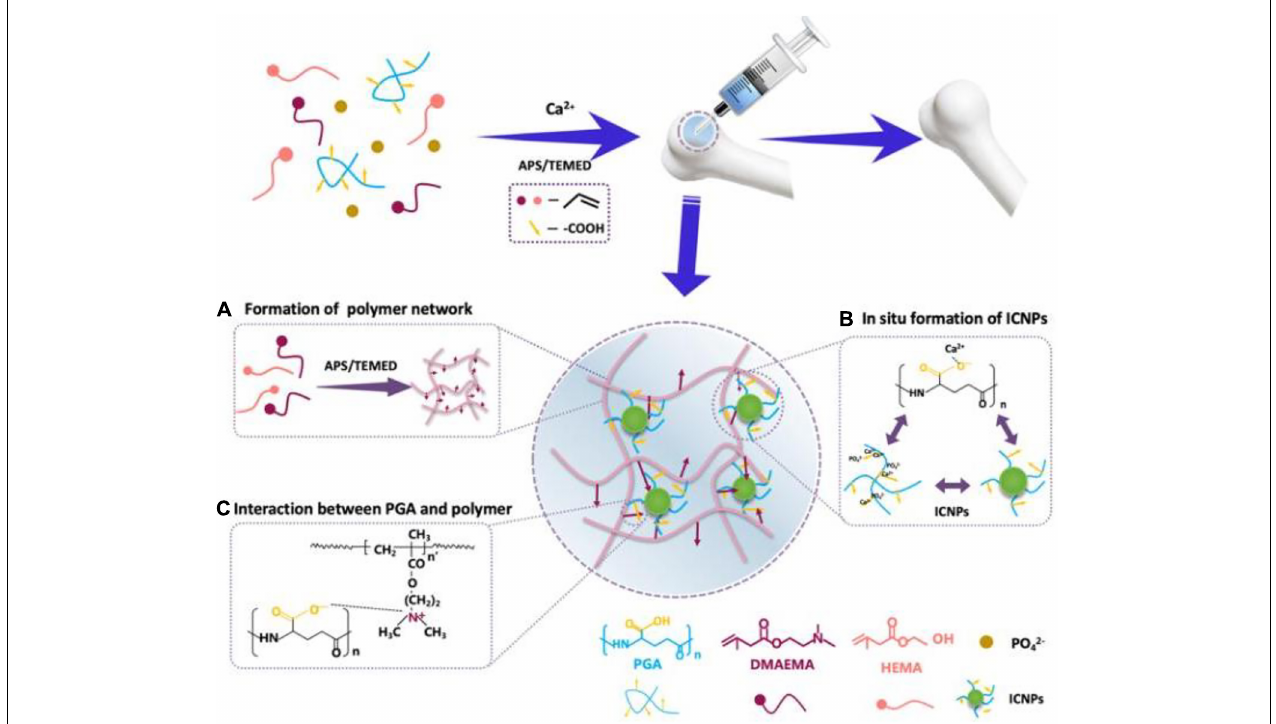
FIGURE 8 | (A) Formation of the polymer network from HEMA and DMAEDA via Michael addition reaction (purple arrows: positive charges of DMAEMA). (B) In situ self-assembly of CaP NPs around -COOH group of PGA via -COO - -Ca 2 + coordination. (C) The interaction between the PGA and the polymer network via electrostatic attraction. Reproduced from ref. Kuang et al. (2019) with permission from the American Chemical Society (Copyright